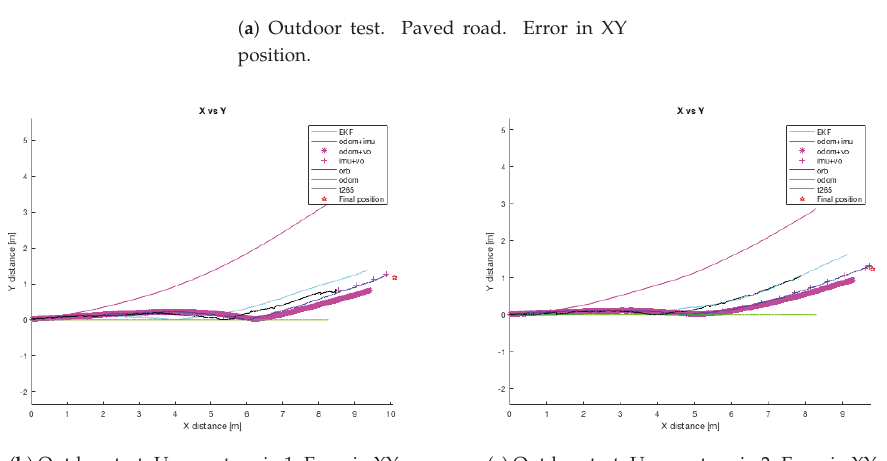
Figure 28. Outdoor test #1.